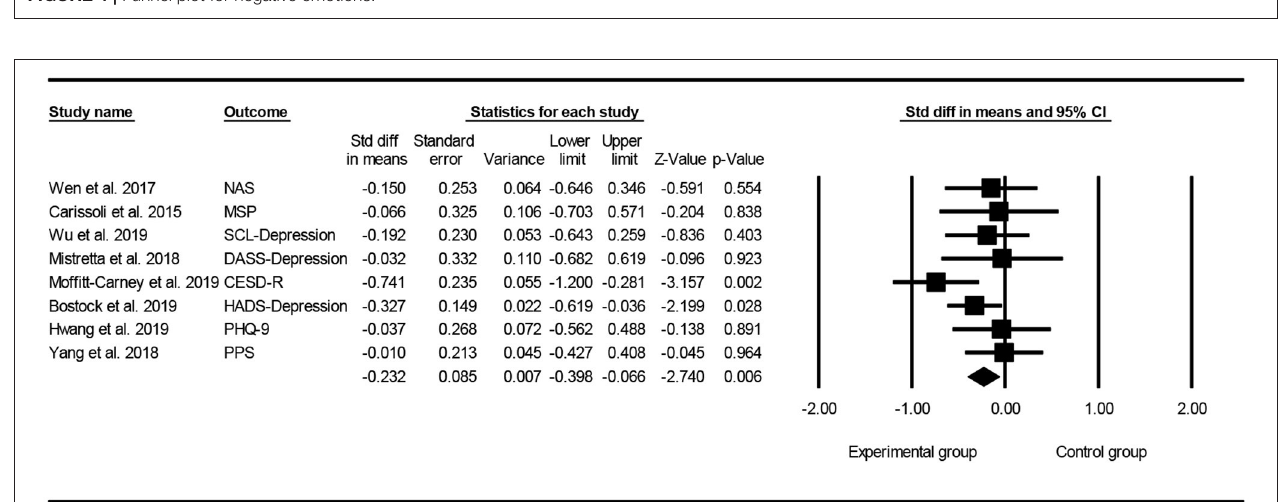
FIGURE 4 | Funnel plot for negative emotions.